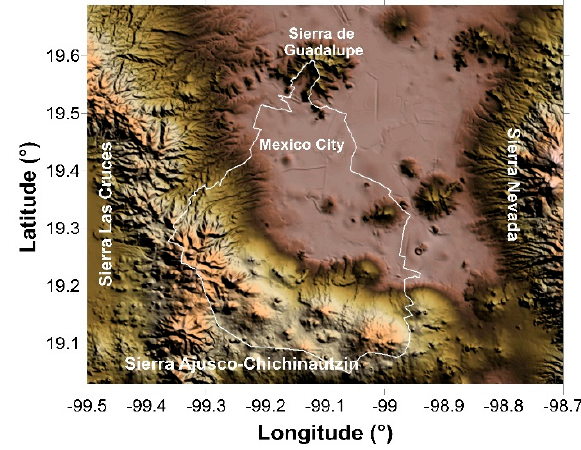
Figure 1. Complex topography in the Mexico City region.